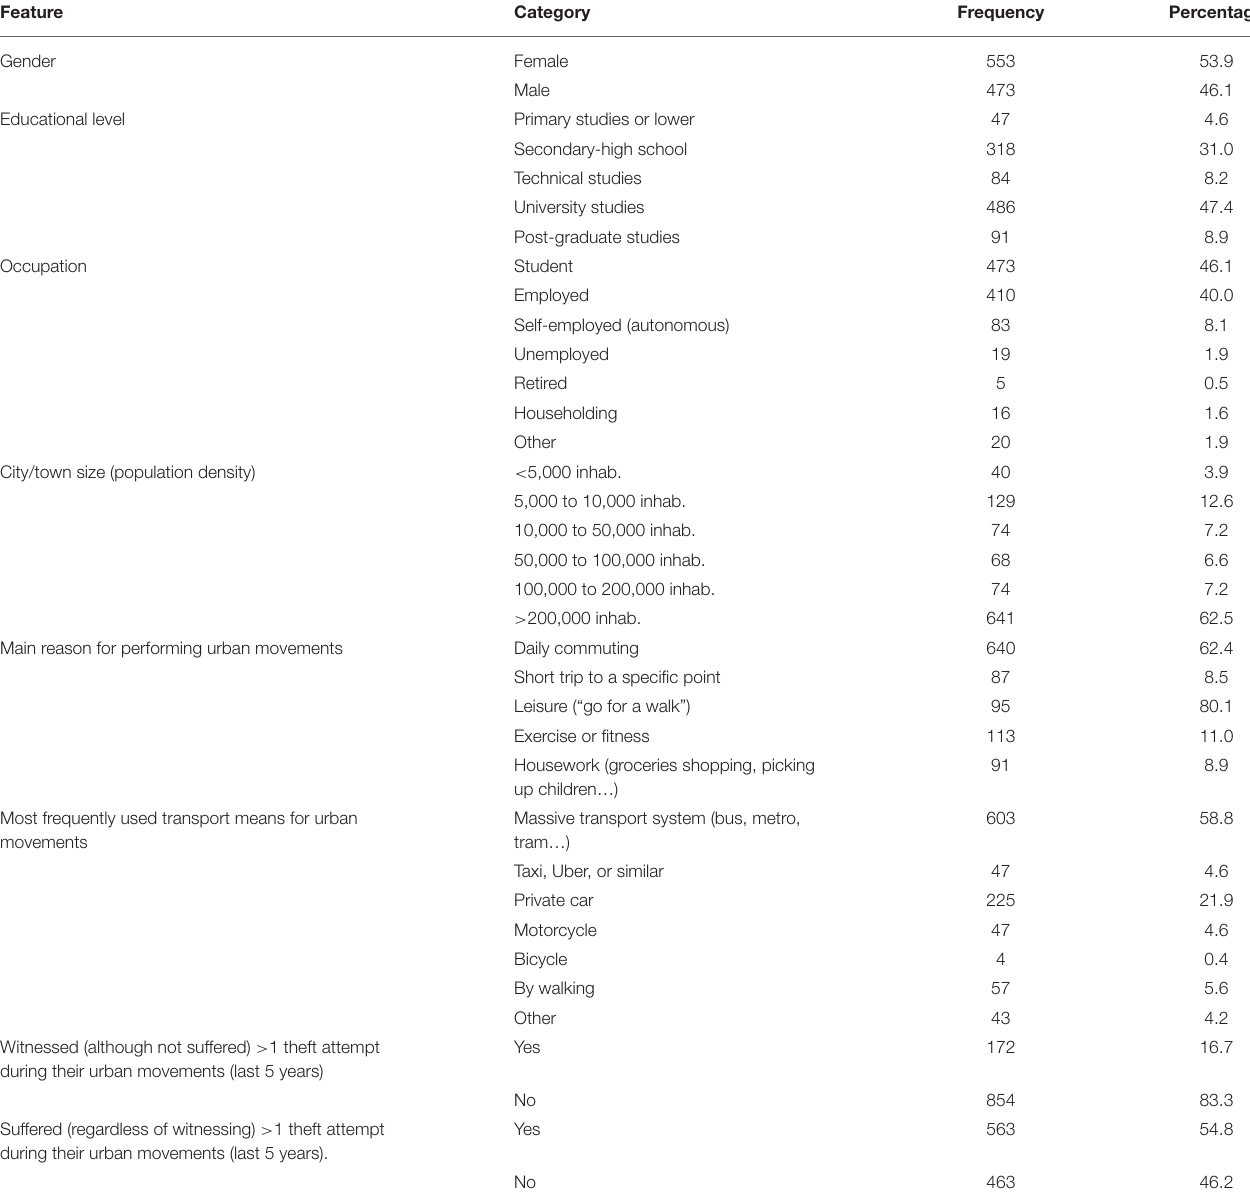
TABLE 1 | Demographic data of the sample and transportation-related indicators.